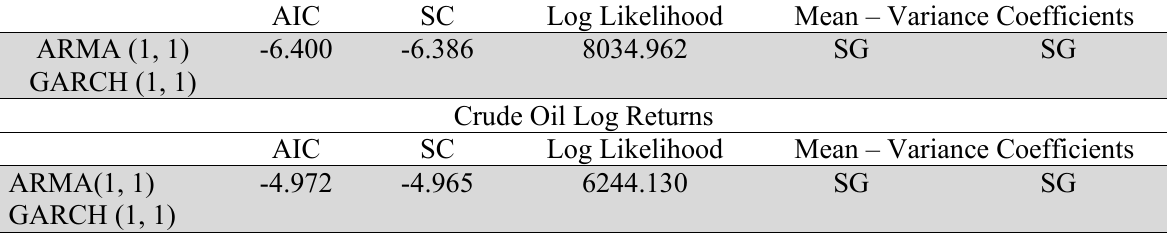
Mean - variance equation results (S&P500 Log Returns)